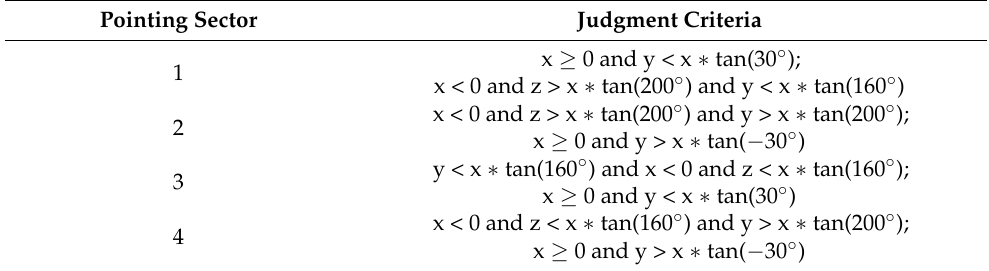
Figure 9. Pointing sector division. Table 2. Pointing sector division judgment